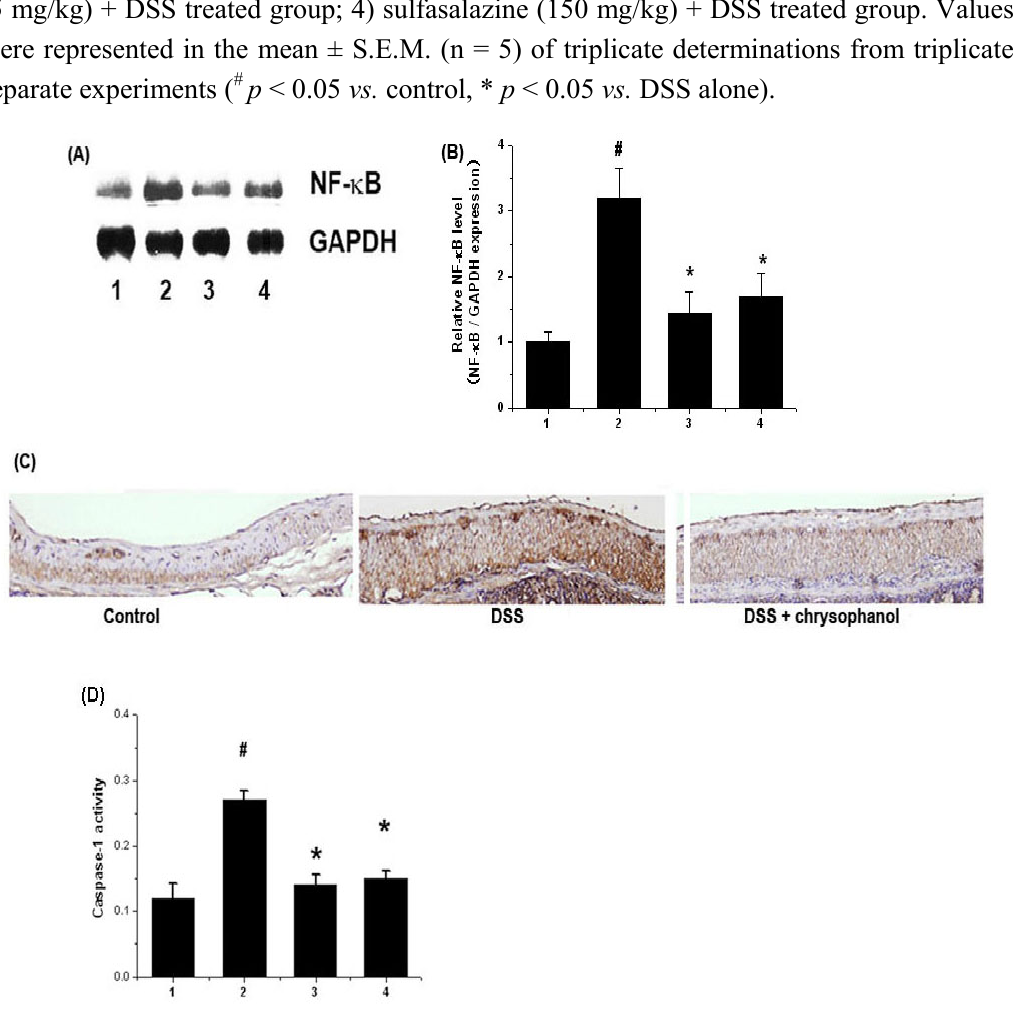
Figure 3. Effects of chrysophanol on the activation of NF- κ B p65 and caspase-1 in DSS-treated colon tissue. At the end of experiment, the colon tissues were cut out and homogenized. (A) The levels of NF- κ B p65 were evaluated by Western blot analysis; (B) The relative expression level of NF- κ B was measured using an image analyzer; (C) Colon were removed and embedded in paraffin, and then 5 μ m sections were prepared and stained with anti-NF- κ B; (D) The enzymatic activity of caspase-1 was evaluated via a caspase colorimetric assay.1) Control group; 2) DSS alone-treated group; 3)